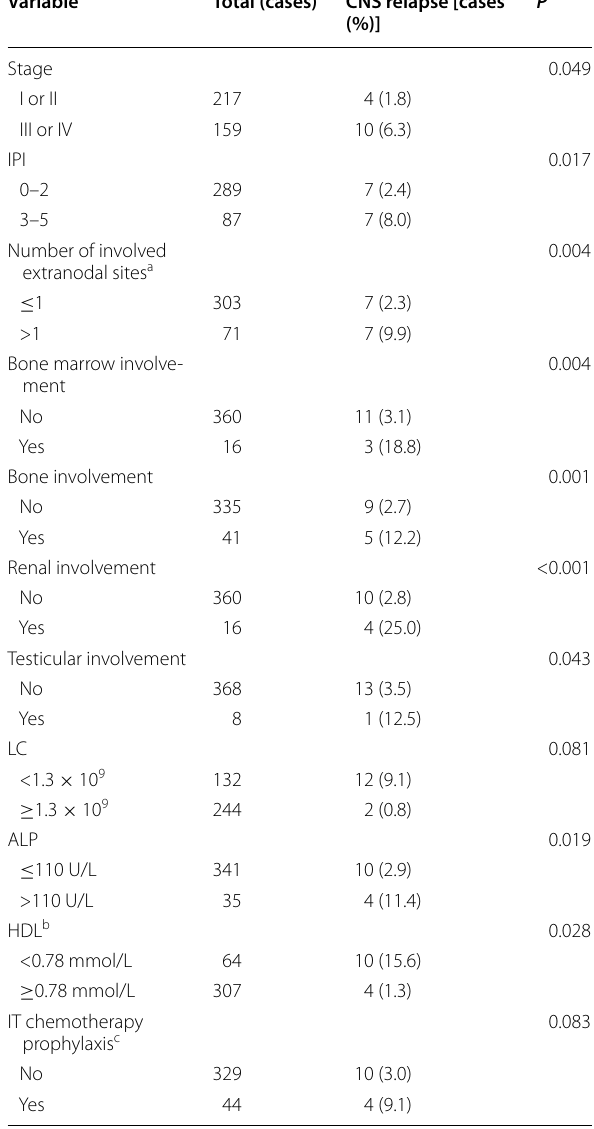
Table 4 Univariate analysis of risk factors for CNS relapse in the R-CHOP